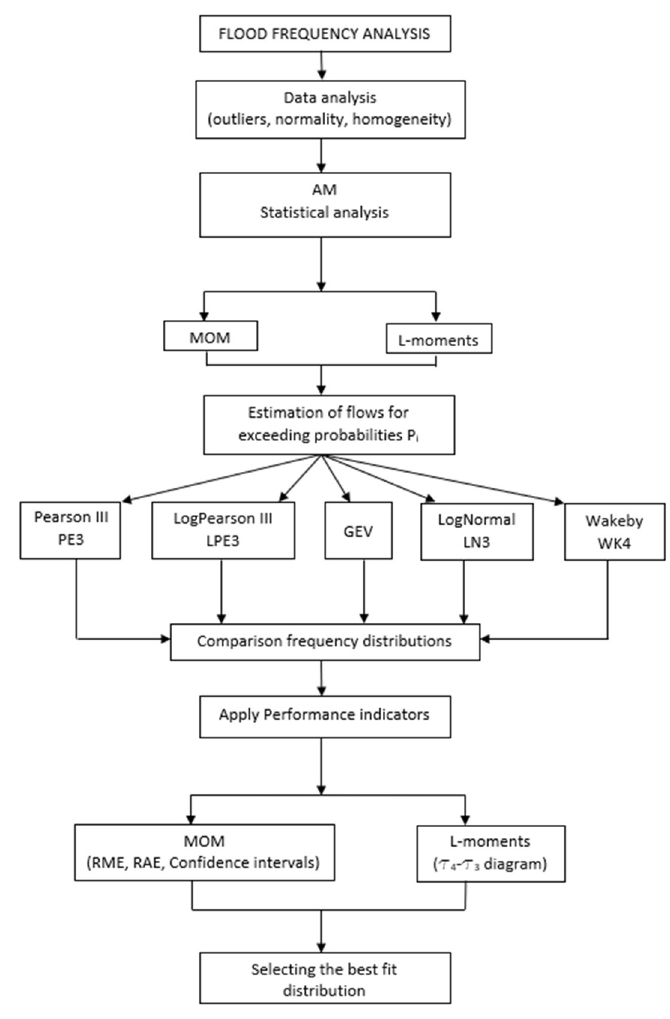
Figure 1. Methodological approach.